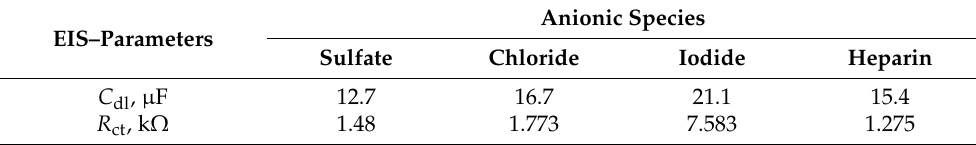
Figure 3. ( A ) Cyclic voltammetric response for the GC/AuNPs/PMS-modified electrodes (scan rate: 50 mV s − 1 ). ( B ) The EIS spectra recorded for the GC/AuNPs/PMS1-modified electrode towards mono- (NaCl, NaI), di- (Na 2 SO 4 ) and multi- (heparin) charged anionic species. Supporting electrolyte: Table 1. Electrochemical parameters of a GC/AuNPs/PMS1 electrode.